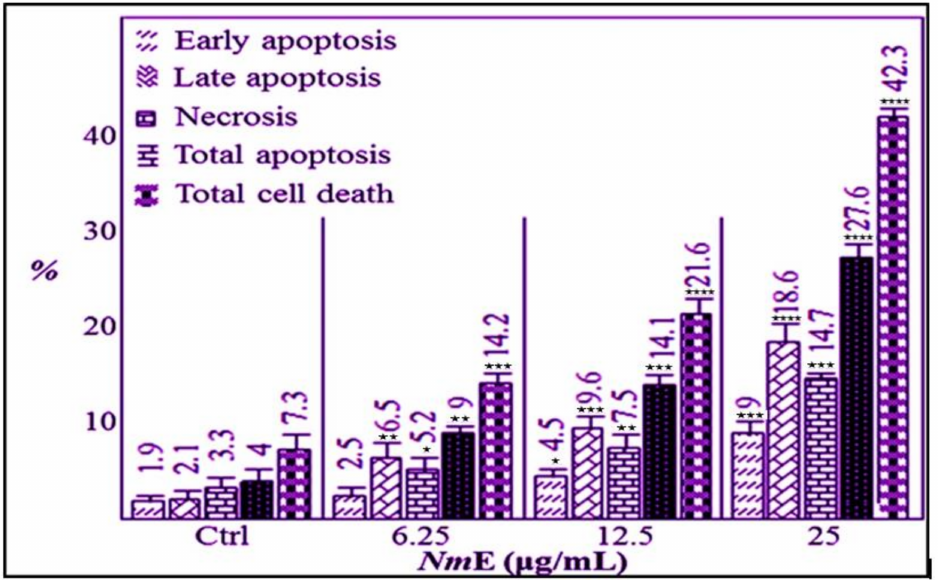
Figure 6. Percentages of apoptosis, necrosis, and cell death induced by Nm E in HepG2 cells. Bars represent the means ± SD. * p < 0.05, ** p < 0.01, *** p < 0.001 and **** p <0.0001 vs. control (DMSO- treated)